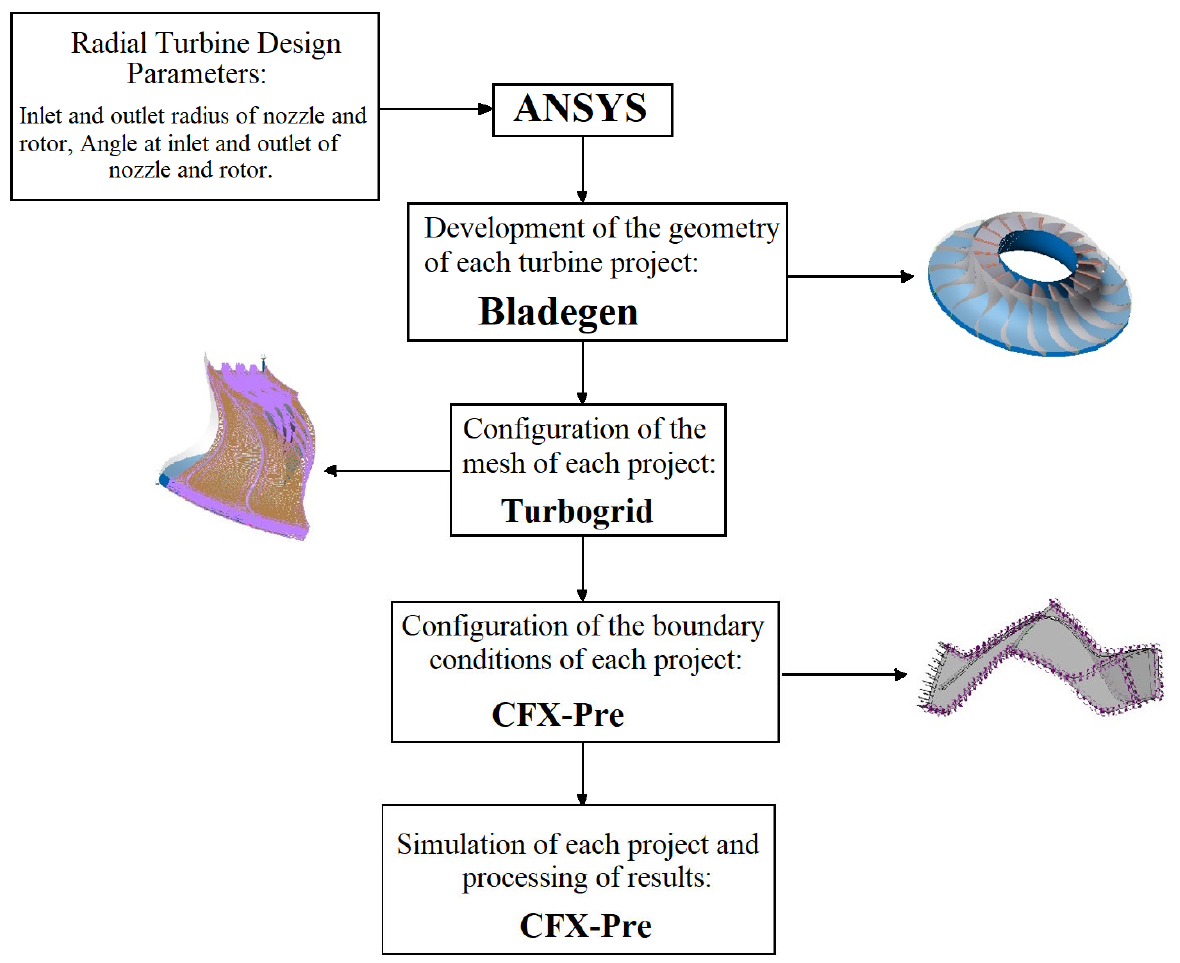
Figure 7. Flowchart of the 3D radial turbine project method.